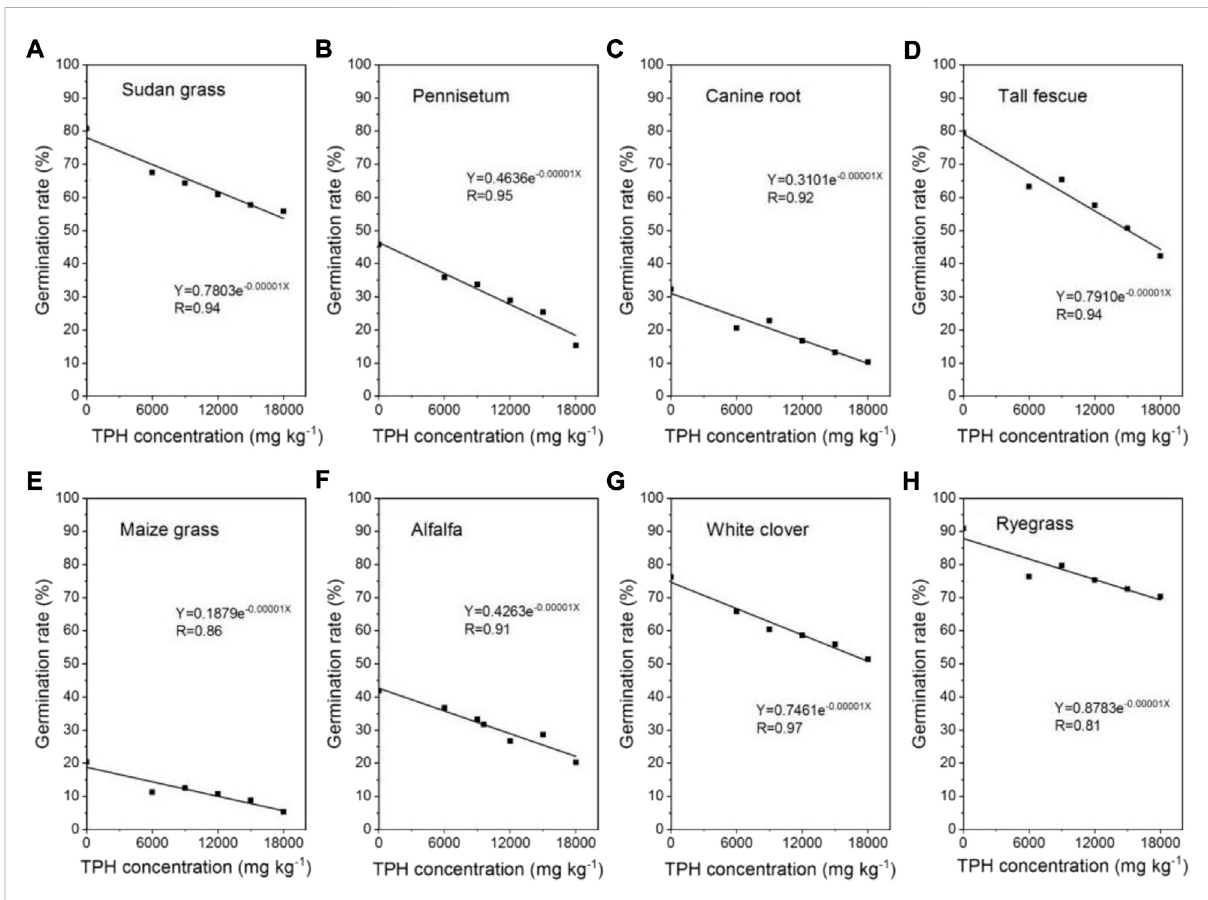
FIGURE 1 Correlation between germination rate of eight plant seeds and petroleum hydrocarbons